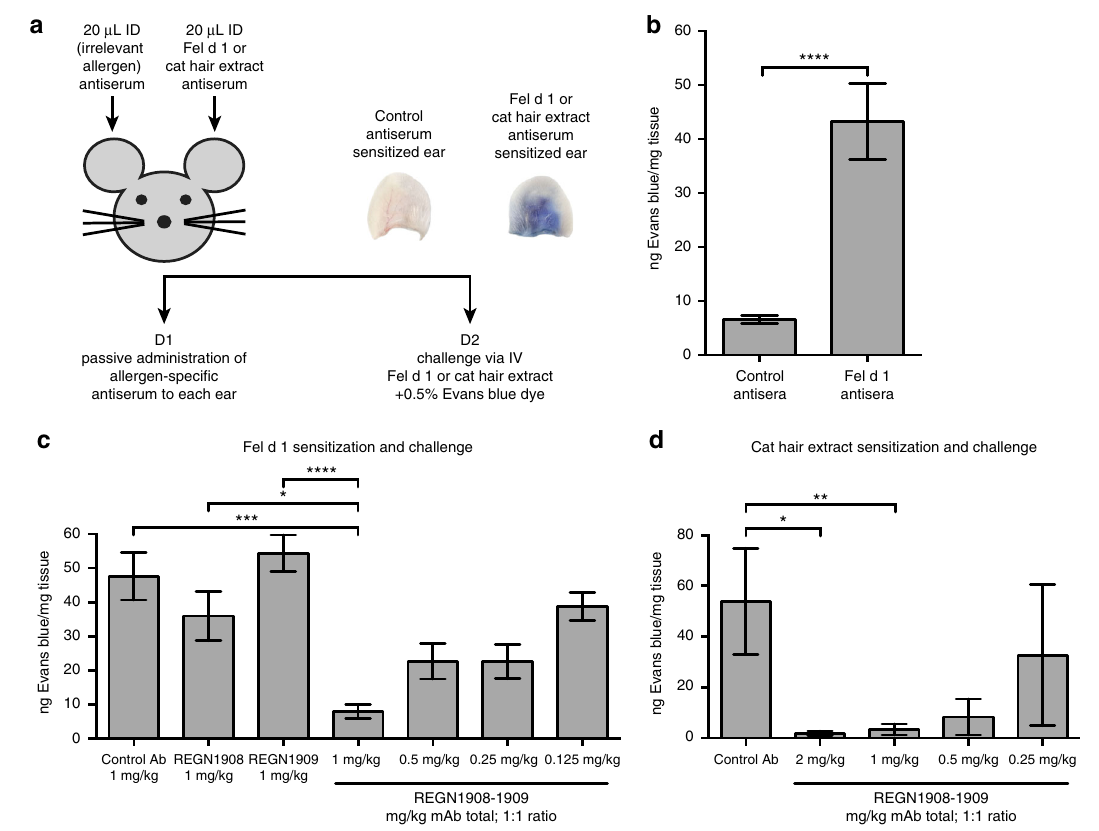
Fig. 3 A combination of REGN1908 – 1909 inhibits Fel d 1-induced mast cell degranulation in vivo in the passive cutaneous anaphylaxis (PCA) mouse model. a Schematic of the PCA mouse model. b Each mouse ( n = 5 in two independent experiments) were sensitized using Fel d 1 antisera and control peanut antisera in the left and right ears, respectively, followed by challenge with 1 μ g nFel d 1 one day later. Data from the pooled experiments are expressed as ng of Evans blue extracted per mg of ear tissue from ears sensitized with control antisera or ears sensitized with peanut antisera. Statistical analysis was performed using a two-tailed paired t -test. c Balb/c mice were administered subcutaneous (SC) doses of REGN1908 ( n = 15), REGN1909 ( n = 15), a combination of REGN1908 – 1909 (1:1 ratio) at 0.125 mg/kg ( n = 15), 0.25 mg/kg ( n = 15), 0.5 mg/kg ( n = 15), or 1 mg/kg ( n = 14), or an IgG4 P control antibody ( n = 14) 3 days prior to initiating the PCA model using Fel d 1-speci fi c antisera (normalized to 25ng IgE per ear) and 1 µ g Fel d 1 challenge. The number per group represents pooled data from three independent experiments. d Balb/c mice were administered SC injections of a combination